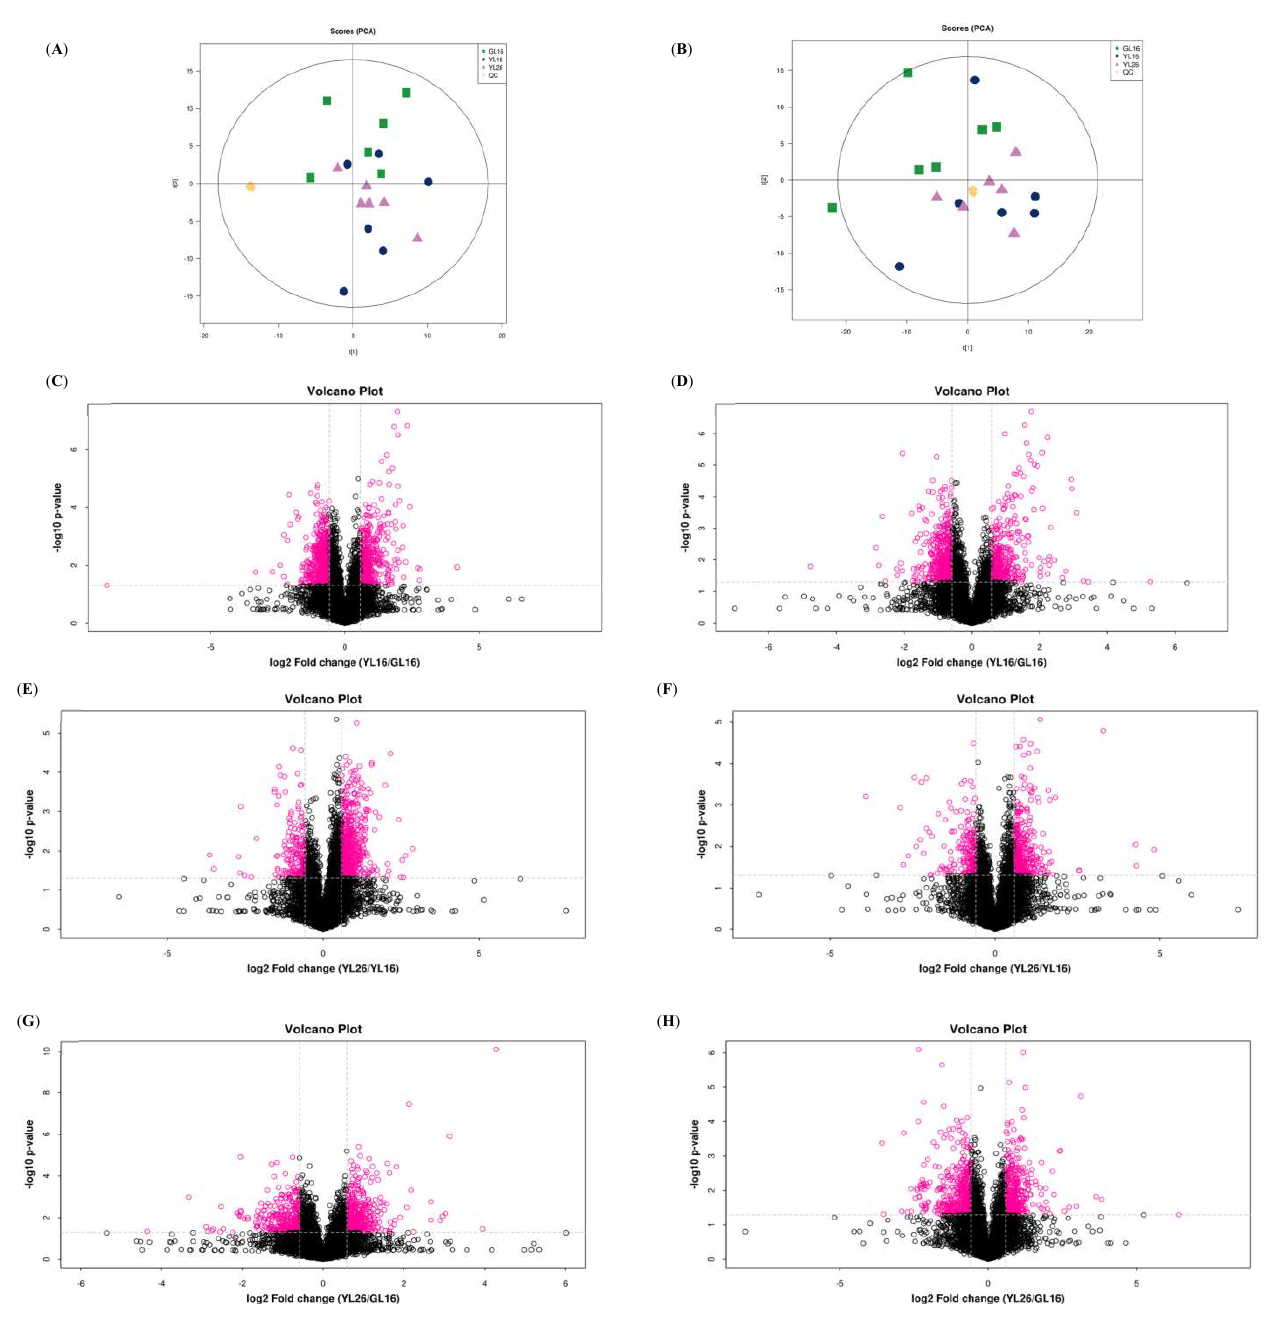
Figure 4 . Metabolite profiling analysis of liver samples. Scatter plots of the PCA model based on all identified metabolite features of liver samples from the cattle in ( A ) positive mode and ( B ) negative mode, including the QC samples. Volcano plots of the comparison between GL16 and YL16: ( C ) positive mode, ( D ) negative mode; between YL16 and YL26: ( E ) positive mode, ( F ) negative mode; and between GL16 and YL6: ( G ) positive mode, ( H ) negative mode. GL16 = non−castrated and slaughtered at 16 months of age; YL16 = castrated at birth and slaughtered at 16 months of age; YL26 = castrated at birth and slaughtered at 26 months of age.